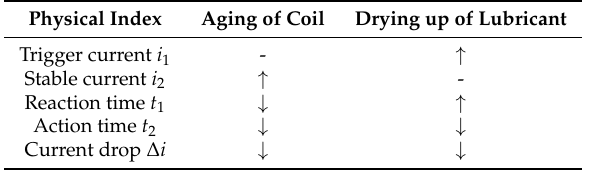
Table 2. Relationship between physical indices and failure